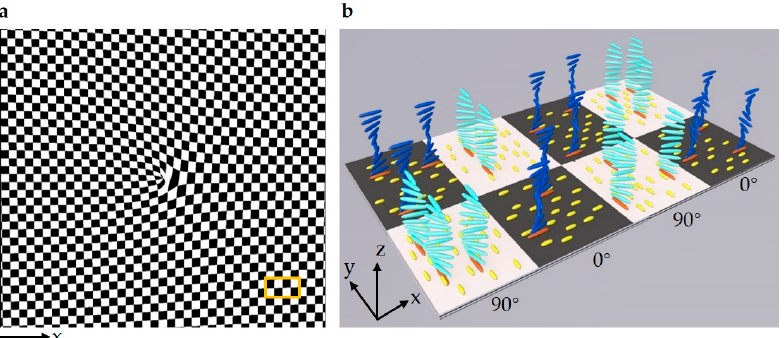
Figure 1. ( a ) The binary phase pattern of a 2 × 2 Damman vortex grating (DVG) with m x = 1 and m y = 3. ( b ) A schematic of liquid crystal (LC) directors in the yellow rectangle region labeled in ( a ).